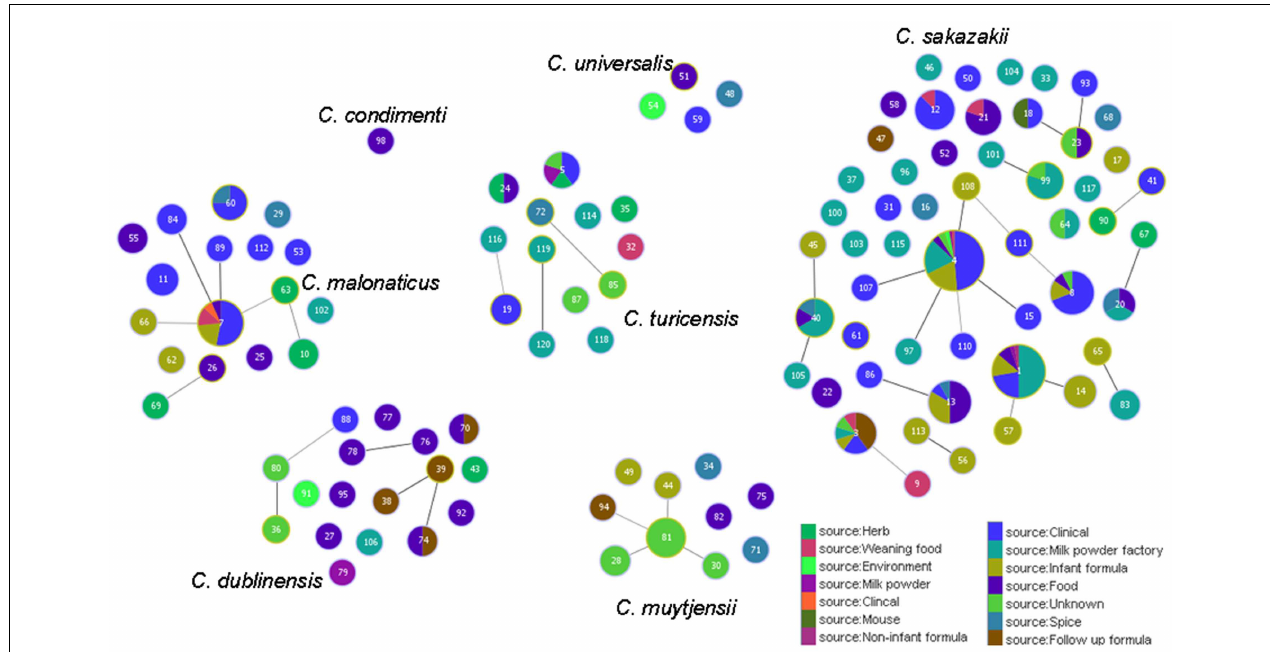
FIGURE 7 | Population snapshot of the Cronobacter MLST database generated using the goeBURST algorithm, indicating the clonal complexes and the diversity of the sources of the strains. The threshold for the output was set to triple locus variation.The dominant STs are represented by the circles with larger diameters.